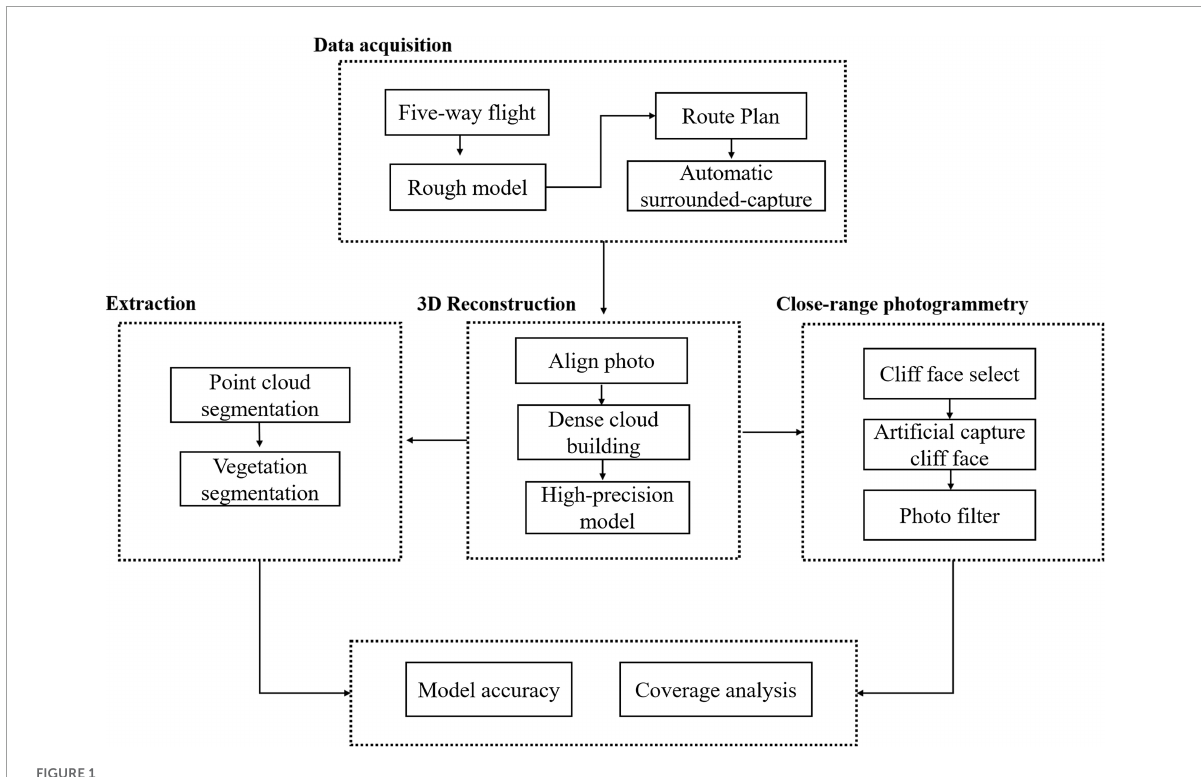
FIGURE1 Flow of the cliff three-dimensional (3D) model